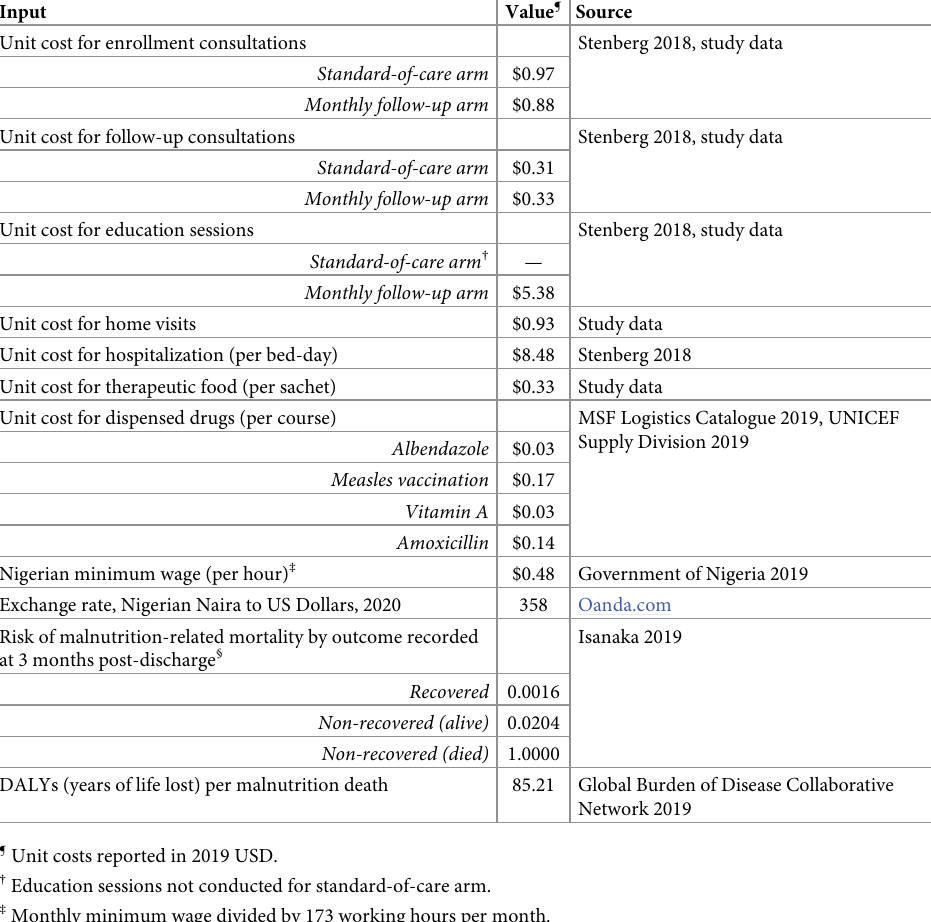
Table 1. Inputs for cost-effectiveness